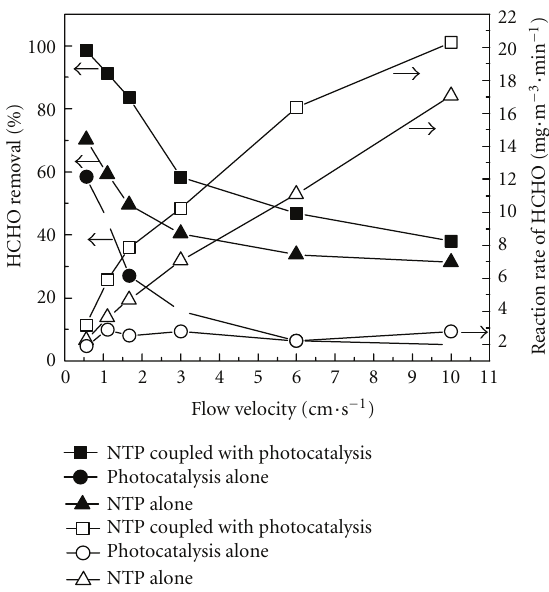
Figure 10: The e ff ect of flow velocity on the HCHO removal and reaction rate by di ff erent